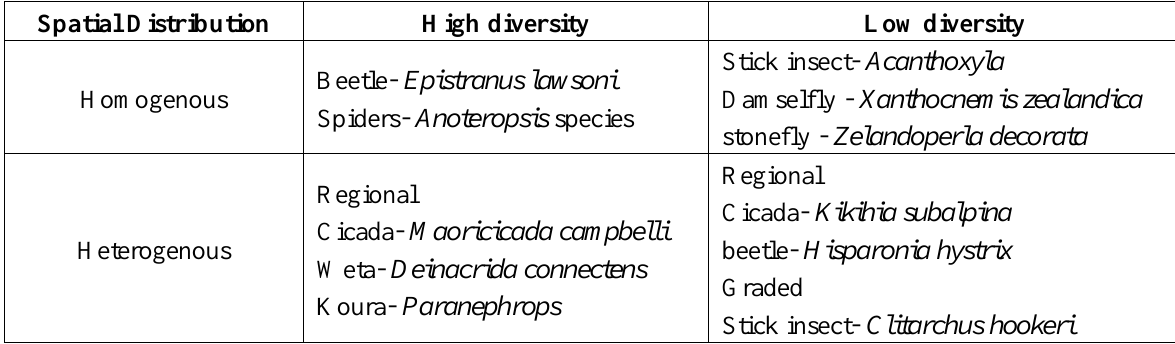
Table 4. Exemplars of New Zealand invertebrate phylogeography studies matching hypothetical extremes in terms of depth of diversity and patchiness of diversity. See Tables 2 and 3 for additional